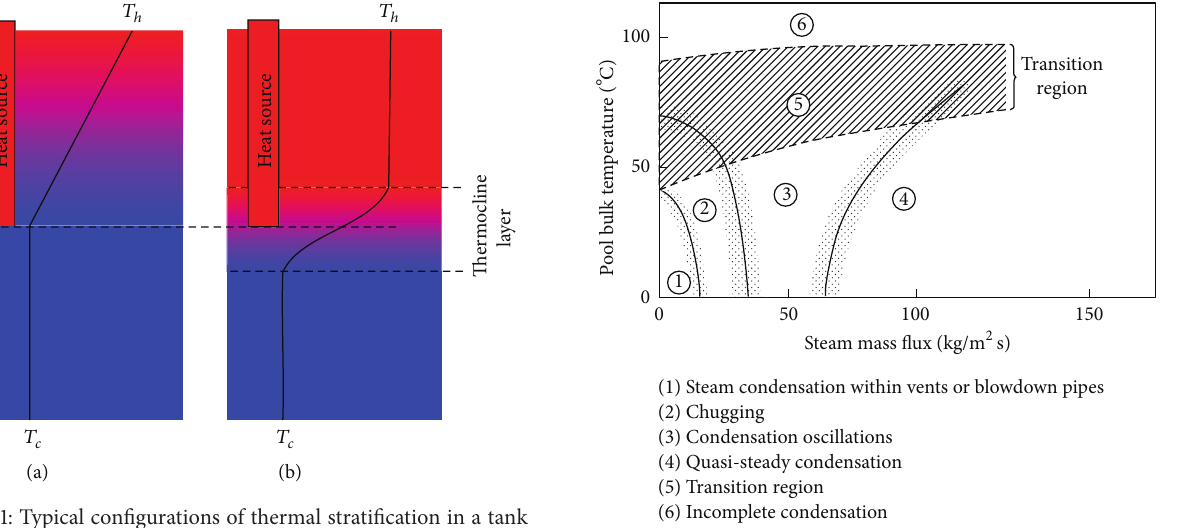
Figure 2: Regime map of steam condensation